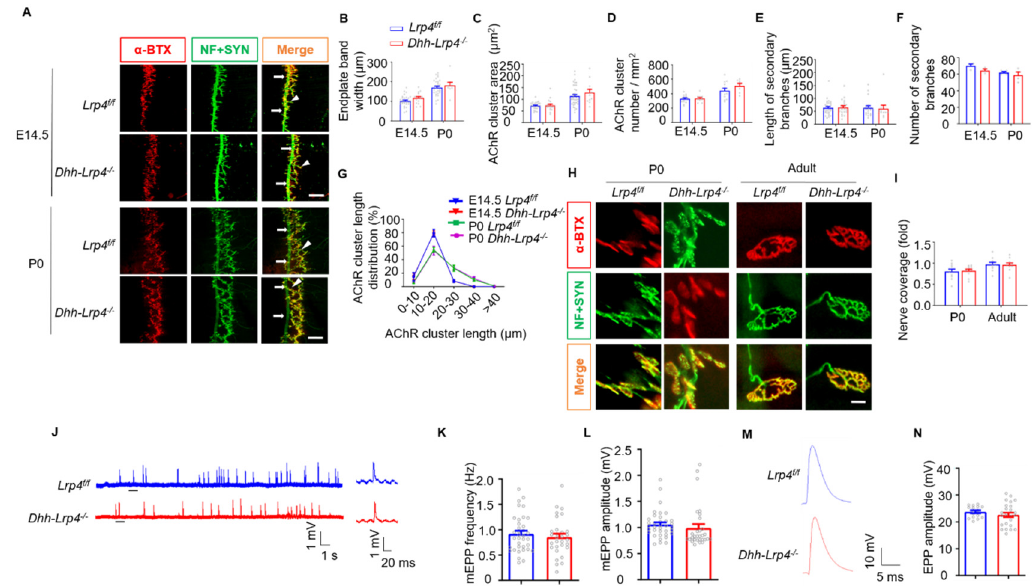
Figure 8. Lrp4 deficiency in SCs does not influence NMJ formation or transmission. ( A ) Representative images of the diaphragms of control and cKO mice at E14.5 and P0. The left ventral regions of the diaphragms of control and mutant mice at P0 and E14.5 were stained in whole-mount NMJ preparations. The arrow indicates the primary branch. The arrowhead indicates the secondary branch. Scale bar = 50 µ m. ( B ) Comparable endplate bandwidths between the control and cKO mice. Control, n = 29 or 31 regions; cKO, n = 9 or 16 regions, 3 to 5 mice/group. ( C ) Comparable AChR cluster areas between the control and cKO mice. Control, n = 26 or 39 regions; cKO, n = 19 regions, 3 to 5 mice/group. ( D ) Comparable AChR cluster numbers between the control and cKO mice. Control, n = 12 or 15 regions; cKO, n = 11 regions, 3 to 5 mice/group. ( E ) Comparable secondary branch lengths between the control and cKO mice. Control, n = 29 or 22 branches; cKO, n = 21 branches, 3 to 5 mice/group. ( F ) Comparable secondary branch numbers between the control and cKO mice. 3 or 4 mice/group. ( G ) Comparable AChR cluster length distribution between the control and cKO mice of